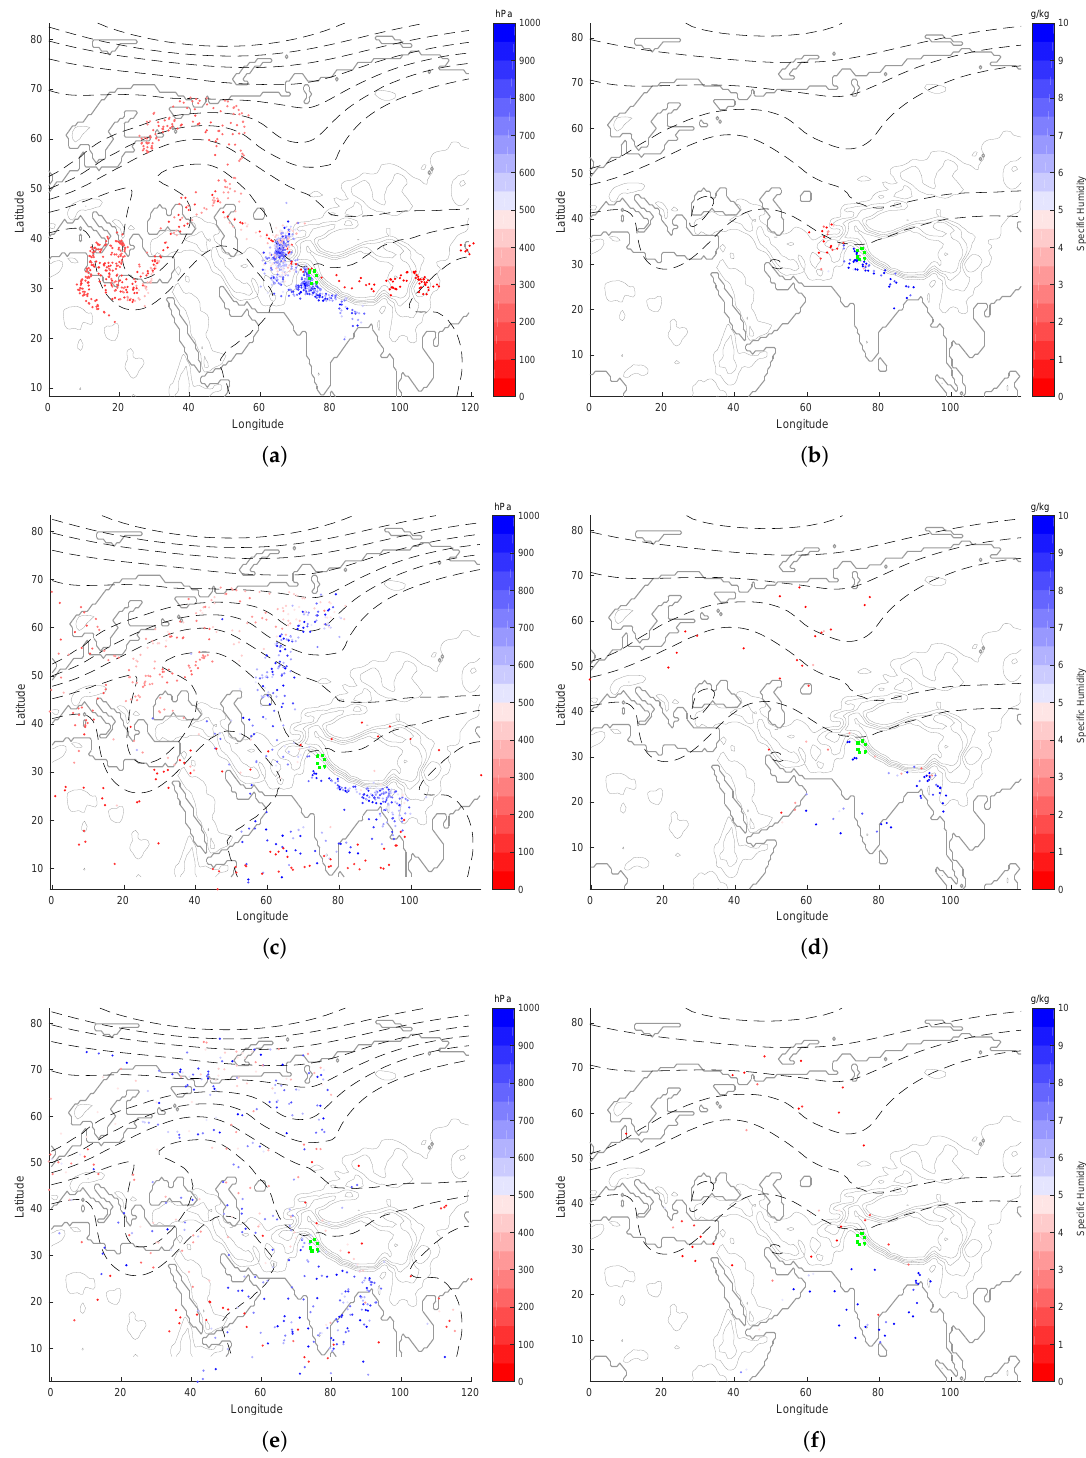
Figure 12. All back-trajectories emanating from U on 16 June 2013. ( a ) parcel pressure, 2 days back in time, along the parcel trajectory; ( b ) parcel pressure, 2 days back in time, along the parcel trajectory; ( c ) parcel pressure, 6 days back in time, along the parcel trajectory; ( d ) specific humidity, 6 days back in time, along the parcel trajectory; ( e ) specific humidity, 10 days back in time, along the parcel trajectory; ( f ) specific humidity, 10 days back in time, along the parcel trajectory. The dashed lines indicate the 5 and 2 day means of 500 mb geopotential height for the left and right columns,